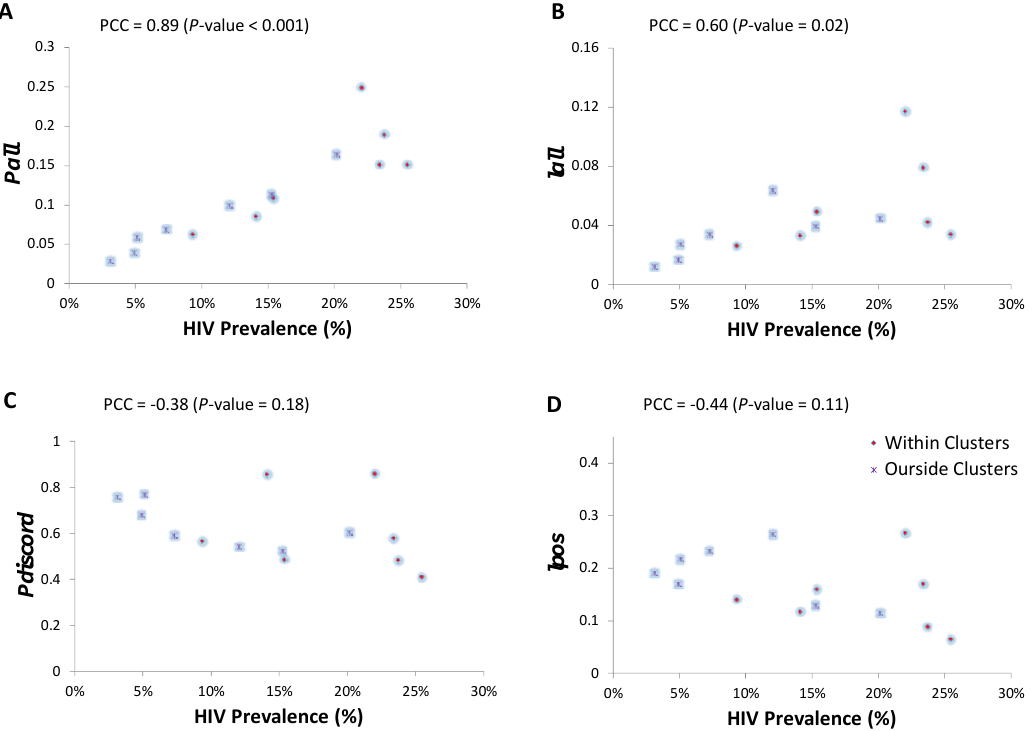
Figure 3. Associations between measures of sero-discordancy and HIV prevalence. ( A ) Scatter plot of the proportion of stable discordant couples among all stable couples ( P all ) versus HIV prevalence within and outside the high HIV prevalence clusters; ( B ) scatter plot of the proportion of individuals engaged in stable HIV discordant couple ( I all ) versus HIV prevalence within and outside the high HIV prevalence clusters; ( C ) scatter plot of the proportion of HIV discordant couples among all stable couples with at least one HIV-infected individual in the couple ( P discord ) versus HIV prevalence within and outside the high HIV prevalence clusters; ( D ) scatter plot of the proportion of all HIV-infected individuals engaged in stable HIV discordant partnerships ( I pos ) versus HIV prevalence within and outside the high HIV prevalence clusters. Correlations were determined using Pearson correlation coefficient (PCC).